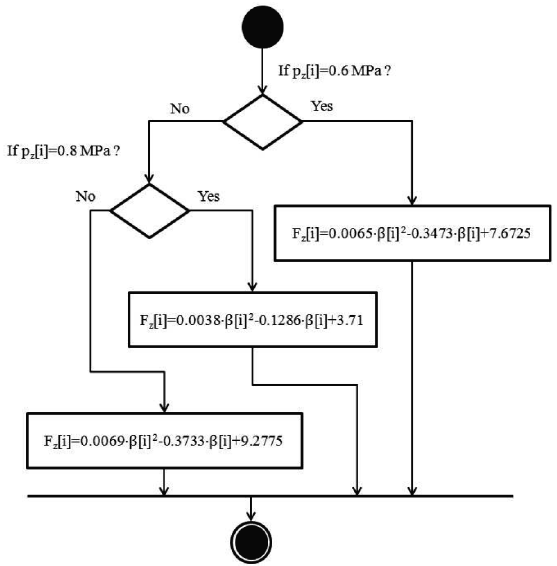
Figure 5. Flowchart of a procedure designed for calculation of sprinkling intensity functions I z